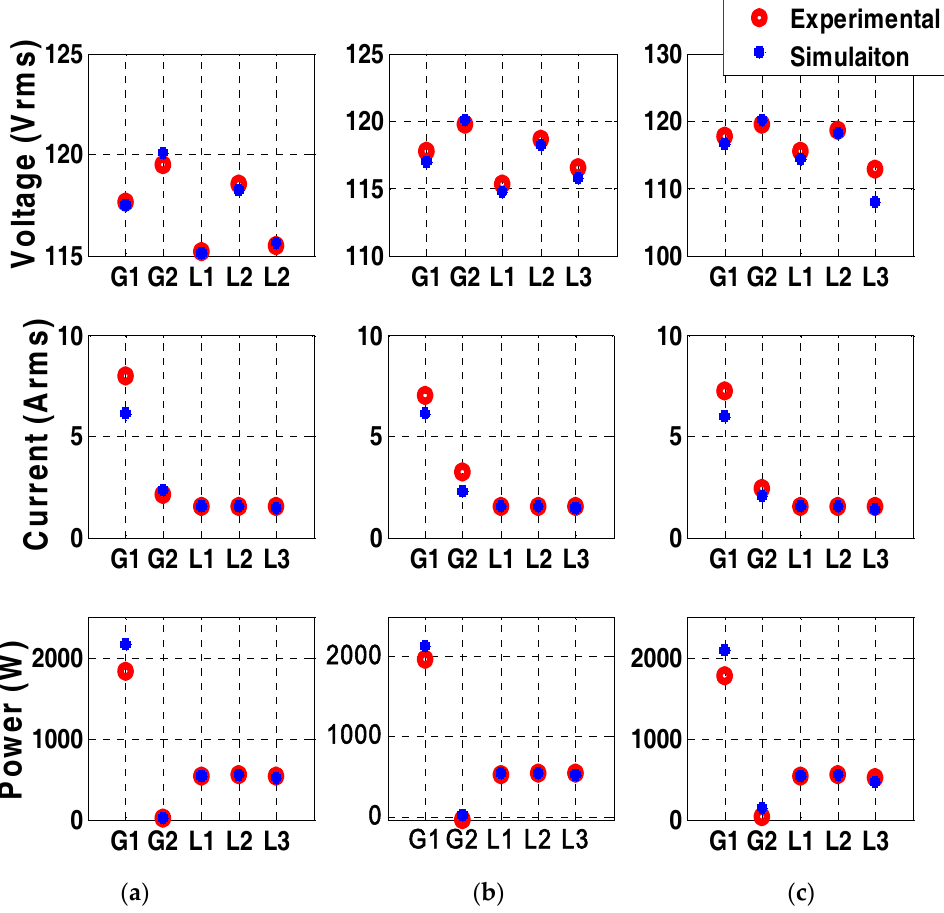
Figure 8. Comparison of the voltage, current, and power on all 5 buses between the simulation model and experimental setup in three cases: ( a ) normal case; ( b ) supplying CL3 from redundant path only; ( c ) under voltage case on CL3. Table 4. Experimental Evaluation of the proposed security system.